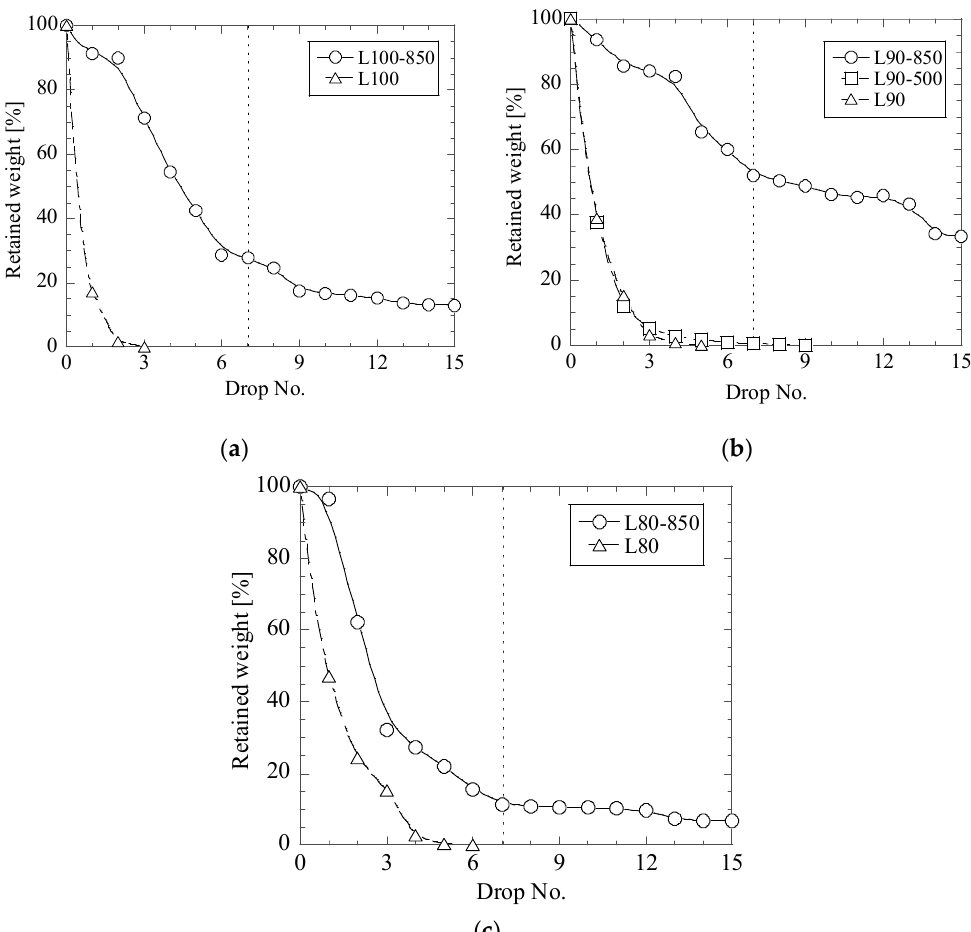
Figure 6. Relationships between retained weight of briquettes L100 ( a ), L90 ( b ) and L80 ( c ) and drop number in drop test trials for di ff erent lime mud briquettes before and after heat treatments at 500 ◦ C and 850 ◦